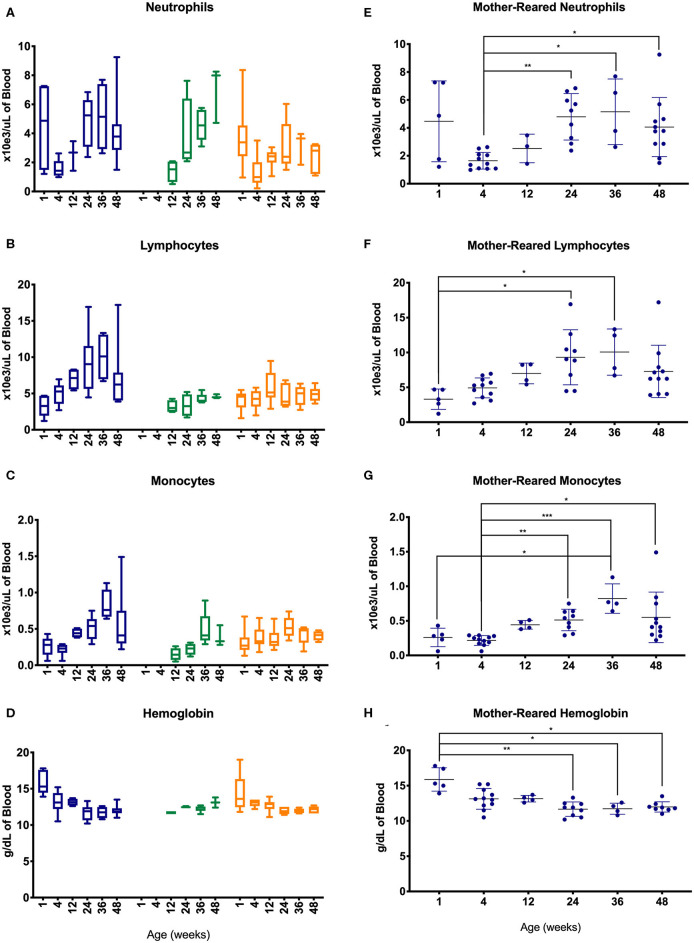
Comparison of selected CBC parameters among pediatric groups of animals over time. Age binning was completed for samples from animals with average ages of 1 week (0–2 weeks old), 4 weeks (3–5 weeks old), 12 weeks (11–13 weeks old), 24 weeks (22–26 weeks old), 36 weeks (34–38 weeks old), and 48 weeks (46–50 weeks old). Data were shown for neutrophil numbers (A), lymphocyte numbers (B), monocyte numbers (C), and hemoglobin (D) in animals from the Colony MR (blue), Colony NR (green), and Research NR (orange). (A–D) were plotted using box and whiskers depicting median, minimum and maximum values and (E–H) applied statistical analyses of results (mean ± st. dev.) from the Colony MR animals using Kruskal-Wallis test coupled with Dunn's multiple comparisons to illustrate how CBC parameters vary with age. *P < 0.05; **P < 0.01; ***P < 0.001.